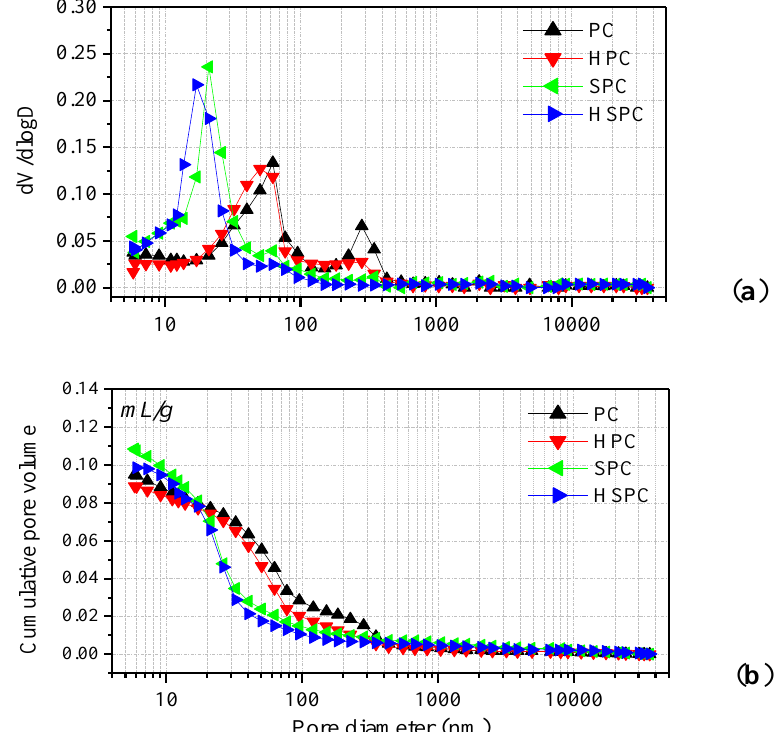
Figure 8. Relation between pore volume ( a ) and cumulative pore volume ( b ) with respect to pore size for composites. Table 5. Pore size distribution of composites.